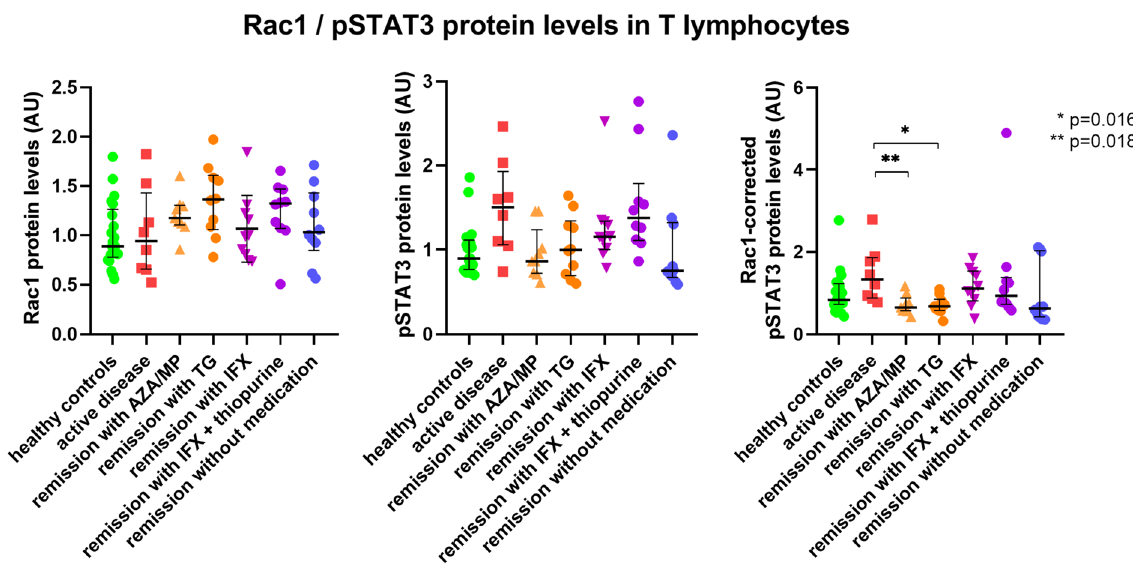
mercaptopurine, TG